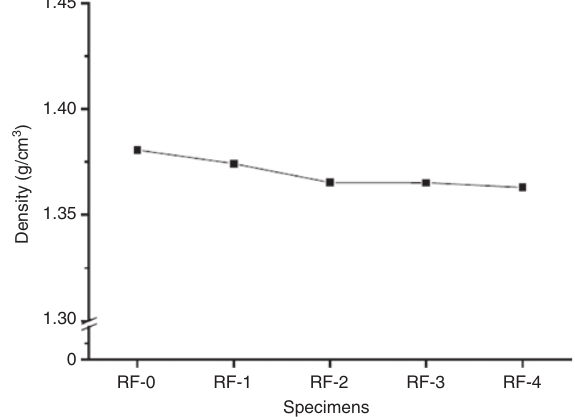
Figure 4 Density curve of CR reinforced with a varying number of polyester tire-cord layers.